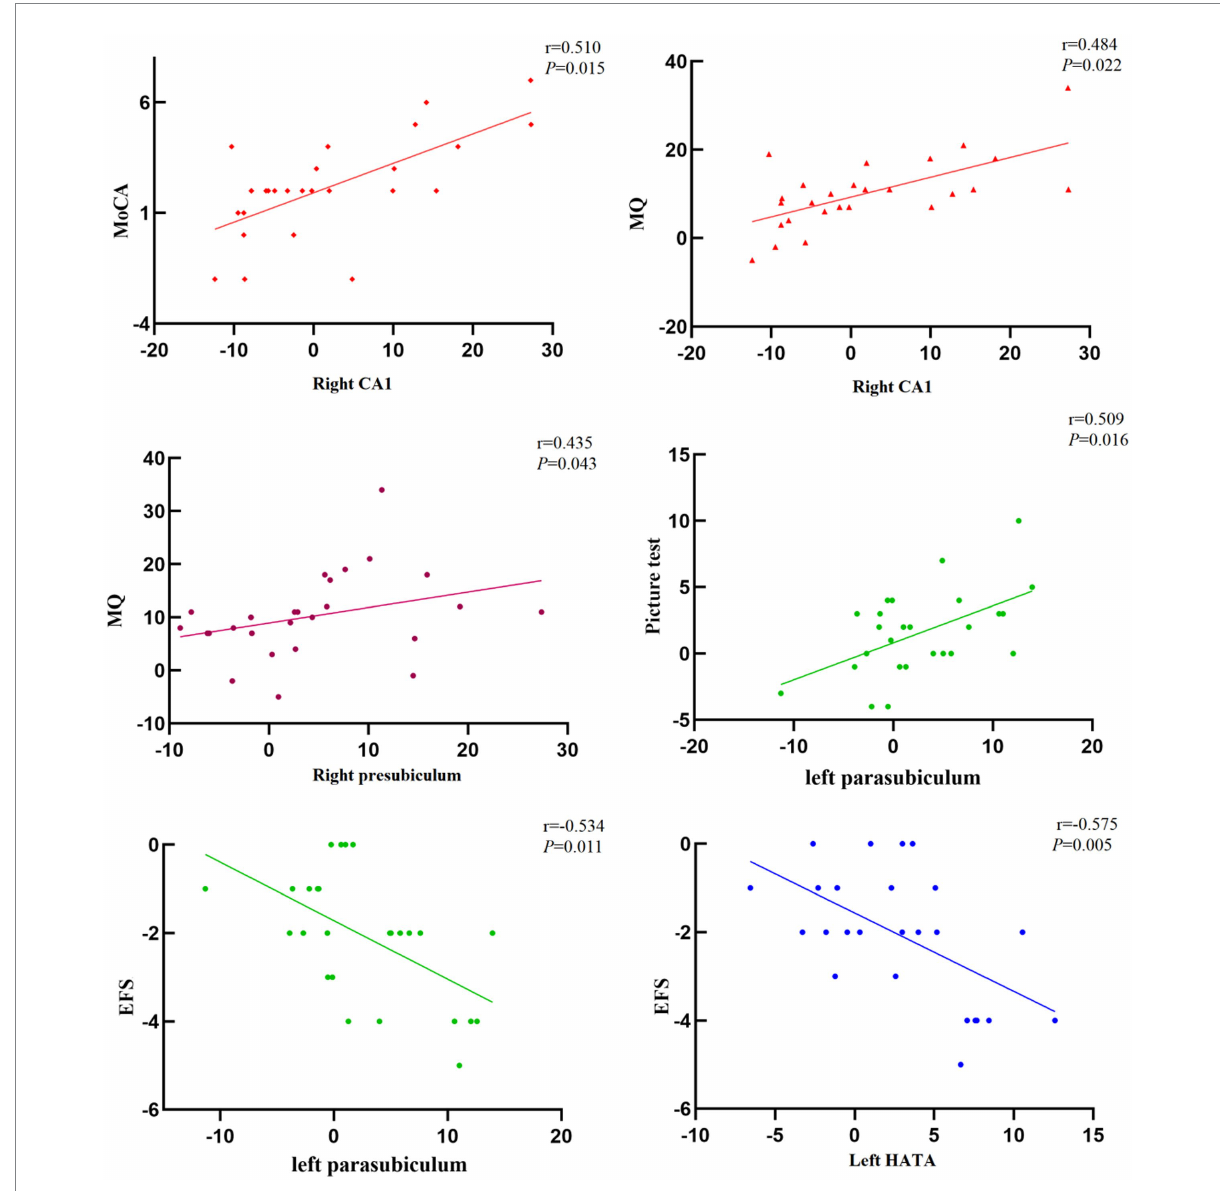
FIGURE 4 Correlation between the volume change of hippocampal subregion and cognitive frailty in Baduanjin group ( n =